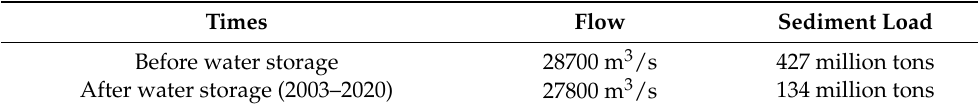
Table 1. Annual average value statistics of flow and sediment at Dotong Station. Times Flow Before water storage